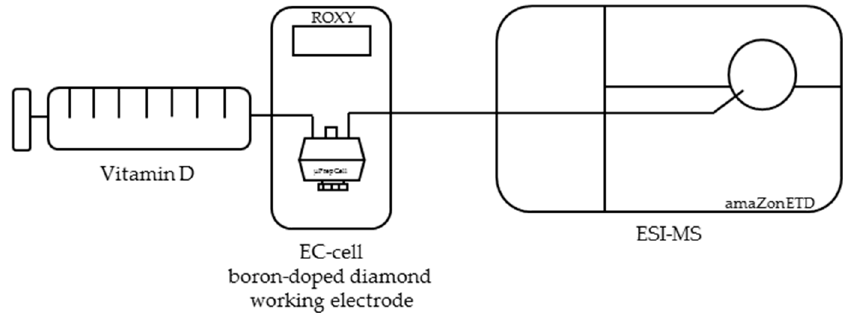
Figure 9. Scheme of the instrumental setup for the electrochemical oxidation of vitamin D using an electrochemistry directly coupled to electrospray ionization mass spectrometry (EC-ESI-MS) system. Vitamin D is oxidized electrochemically via a thin layer cell ( µ -PrepCell) consisting of a boron-doped diamond working electrode and directly detected via electrospray ionization mass spectrometry (ESI-MS).